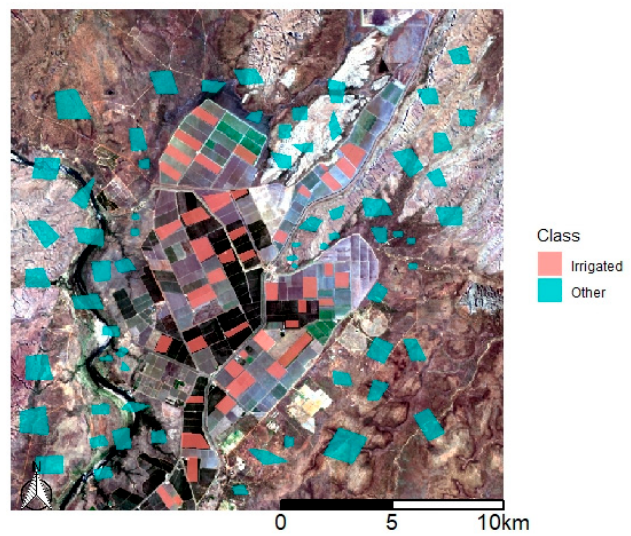
Figure 1. Annual geomedian image of the Ord River Irrigation Area overlaid with hand-drawn polygons labeled as either ‘Irrigated’ or ‘Other’ by visual interpretation, from which 80,000 training and 20,000 validation pixels were randomly sampled for classification.